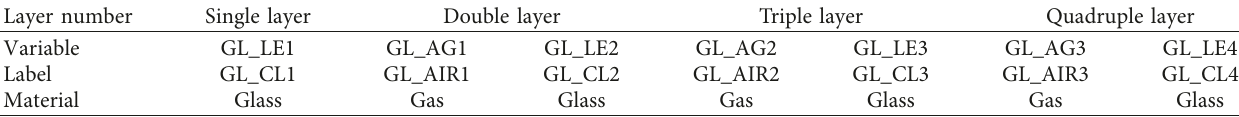
Table 3: Glazing material setting and scale variables for multiple linear regression analysis.